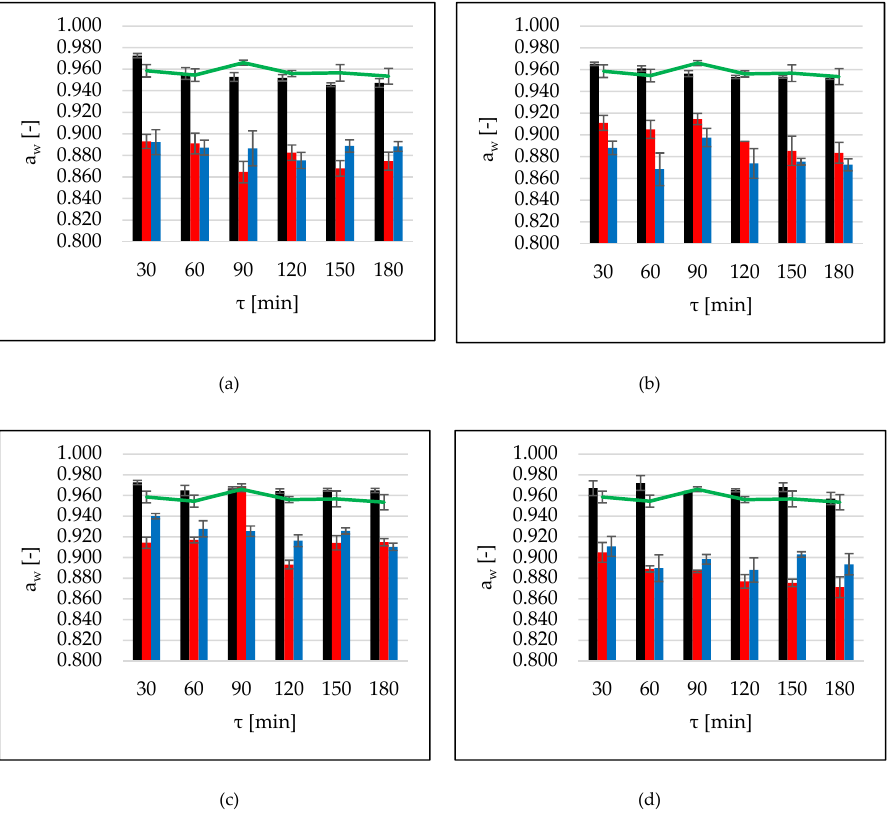
Figure 5. Water activity, a w , at several conditions (OD (black bars), OD+US (red bars), OD+USi (blue bars)) at 40 °C, using different solutions: ( a ) erythritol, ( b ) xylitol, ( c ) maltitol, ( d ) DHA. The green lines are values for the reference (sucrose).